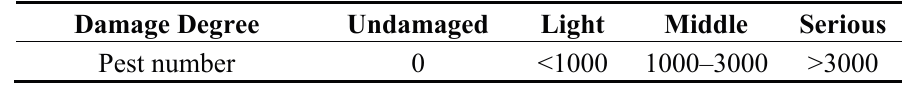
Table 1. Rice plant hopper infestation rating.